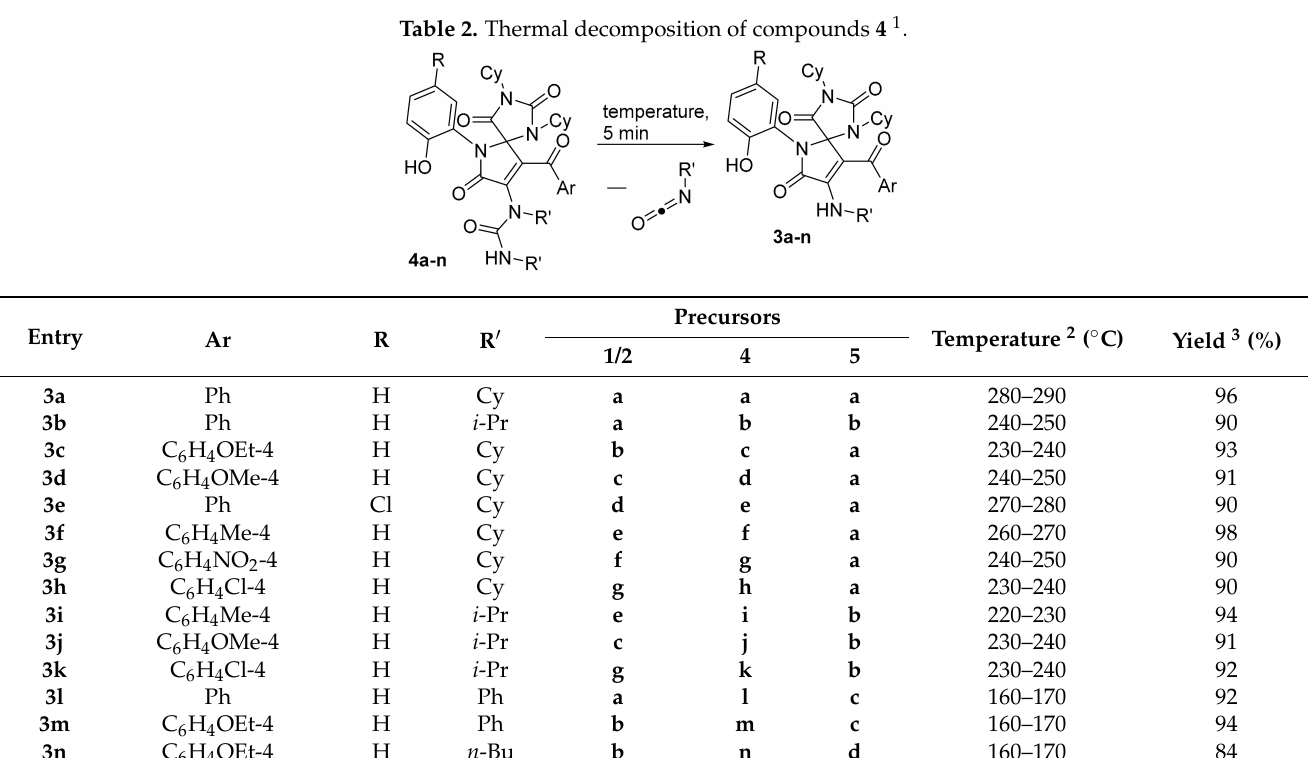
Table 2. Thermal decomposition of compounds 4 1